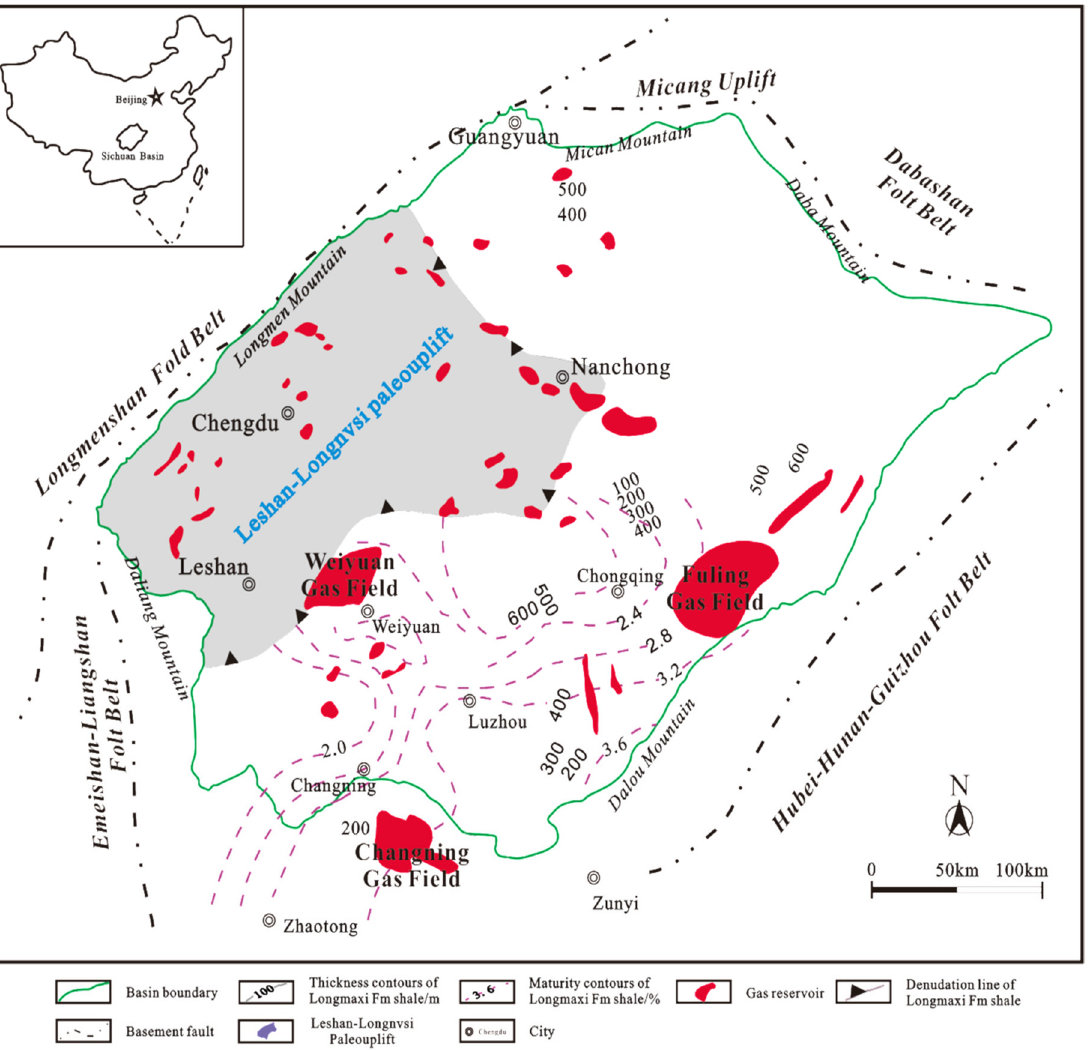
Figure 3. Geological sketch map of the Sichuan Basin, showing the locations of the major shale gas blocks, isolines of Ro values, and the shale thickness of the Longmaxi Formation (created by Cao et al. [56]).